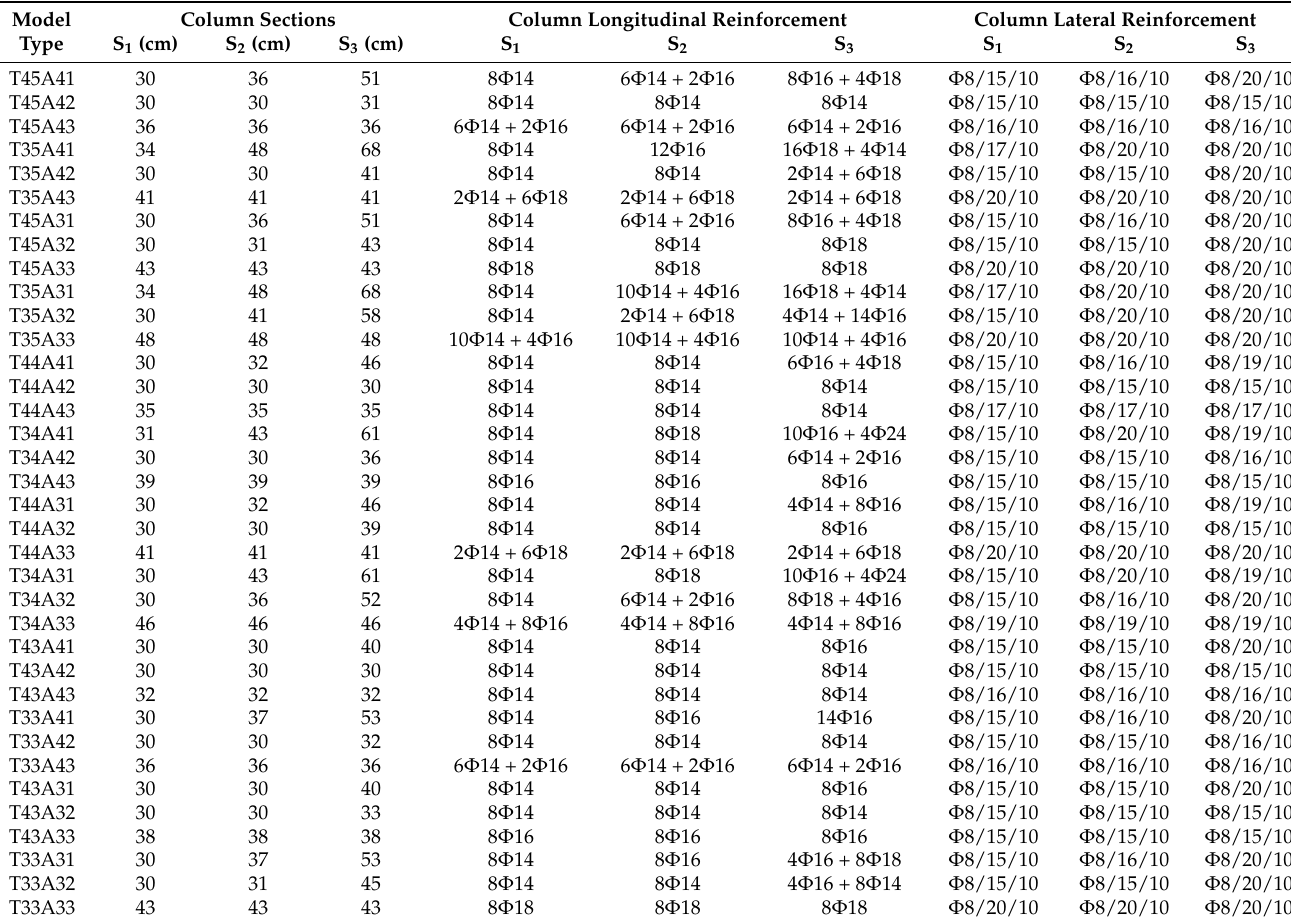
Table 4. Column dimensions and reinforcements details for each